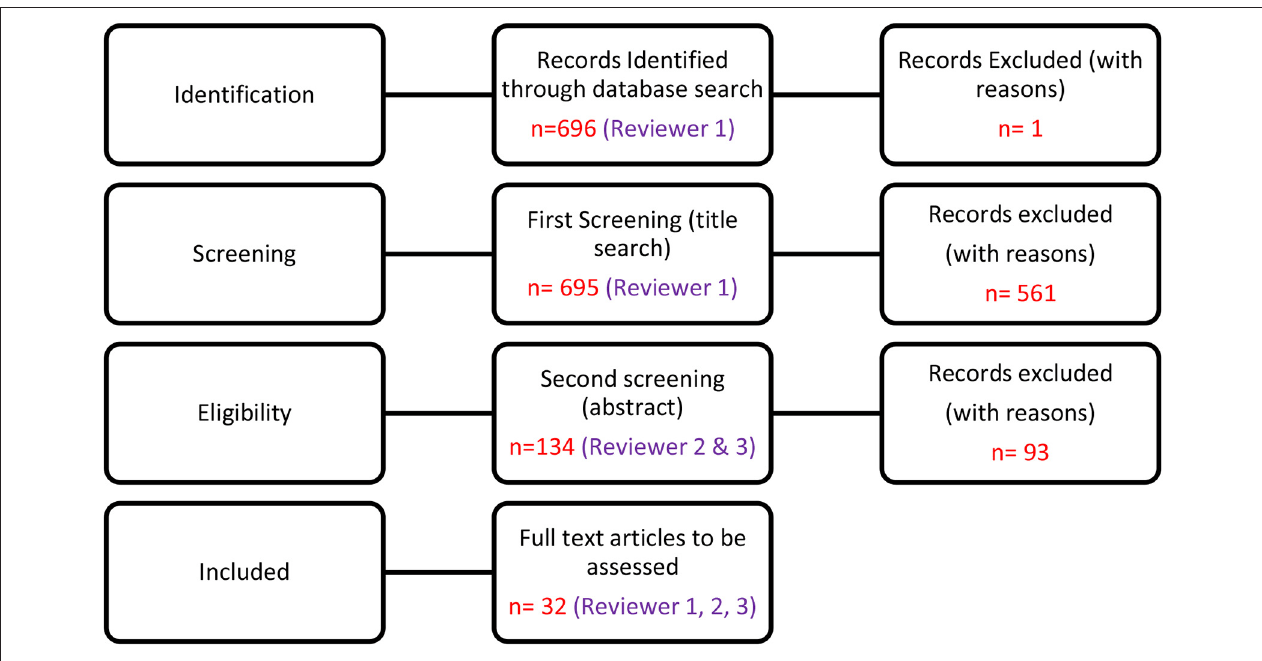
FIGURE 1 | PRISMA diagram to screen